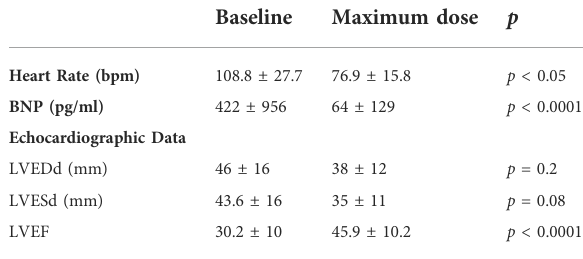
TABLE 2 Effects of heart rate, Brain Natriuretic Peptide and echocardiographic parameters after up titration of carvedilol.